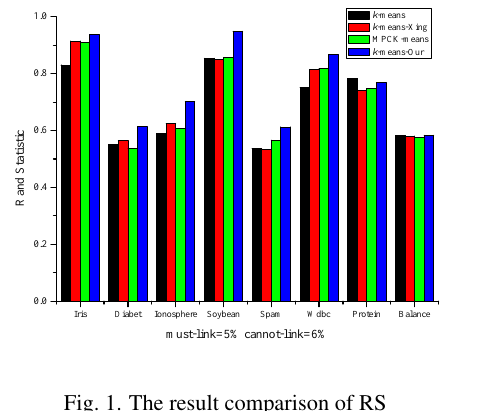
Fig. 1. The result comparison of RS